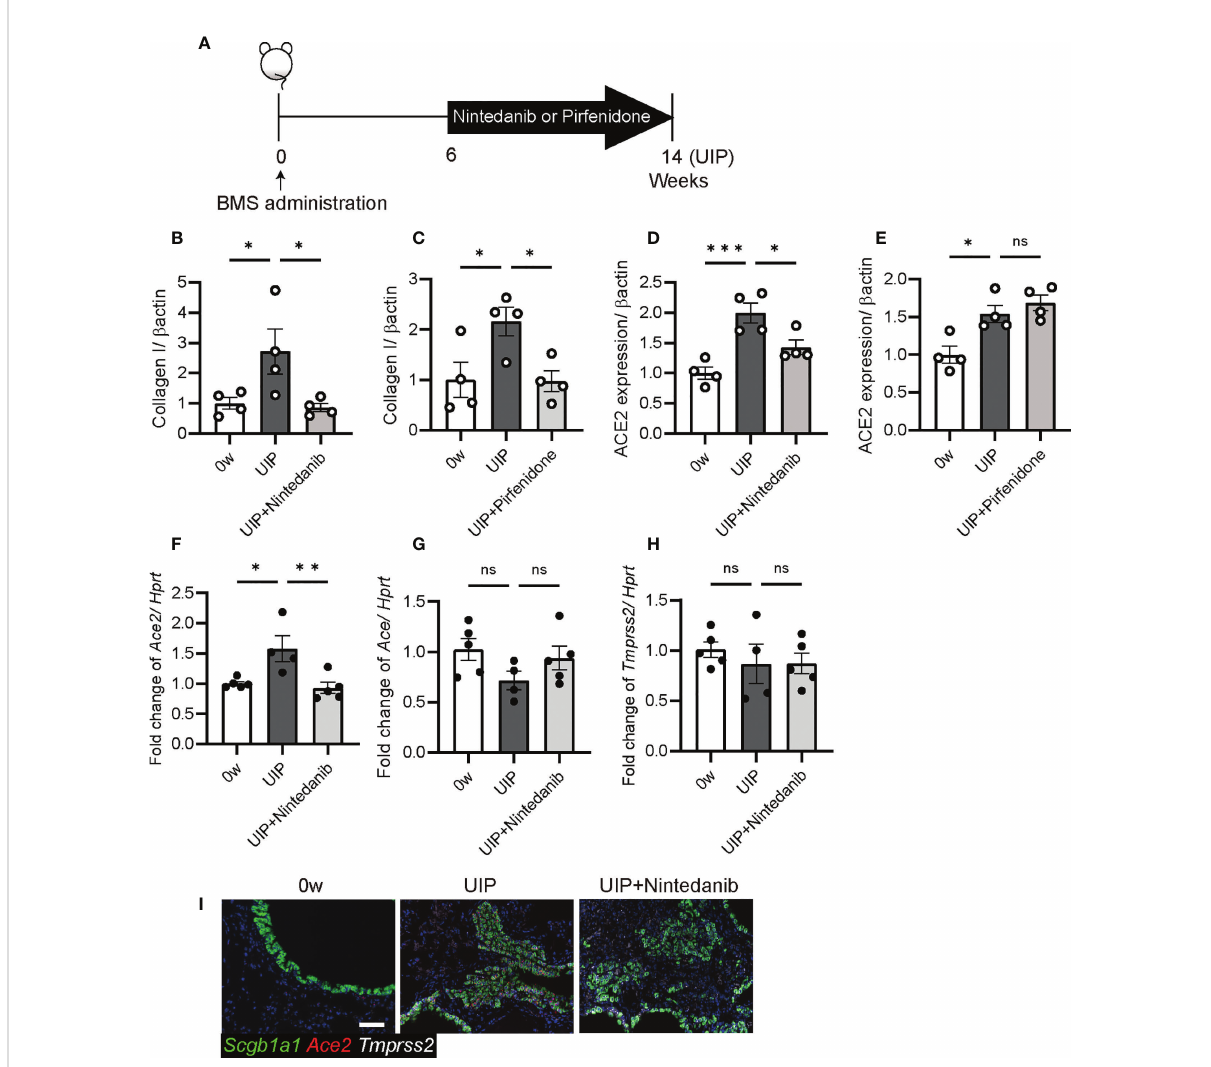
FIGURE 7 Nintedanib attenuated the degree of Ace2 and Ace expression (A) Schematic diagram of protocol for the oral administration of nintedanib or pirfenidone. Both treatments were started from six weeks after BMS administration and were carried out daily for next eight weeks. (B – E) Western blotting was performed using protein extracts from each lung at week 0, the UIP stage, and the UIP stage with nintedanib (UIP+nintedanib) or pirfenidone (UIP+pirfenidone) treatments. (B, C) Nintedanib (B) and pirfenidone (C) decreased the expression of type I collagen at the UIP stage. (D, E) Nintedanib (D) decreased the expression of ACE2, whereas pirfenidone did not (E) . Expression data from western blotting were normalized to b -actin expression levels. (F – H) qPCR were performed using whole lungs from each mouse. Fold changes in expression levels of Ace2 (F) , Ace (G) , and Tmprss2 (H) . Hprt expression was used as an internal control of qPCR. (I) in situ hybridization of Scgb1a1 (green), Ace2 (red), and Tmprss2 (white) in the lungs from each mouse at week 0, the UIP stage, and the UIP+nintedanib. Data are presented as mean ± SE averaged over 4-5 mice. Asterisks indicate * P < 0.05, ** P < 0.01, and *** P < 0.001 compared with week 0. “ ns ” is not statistically signi fi